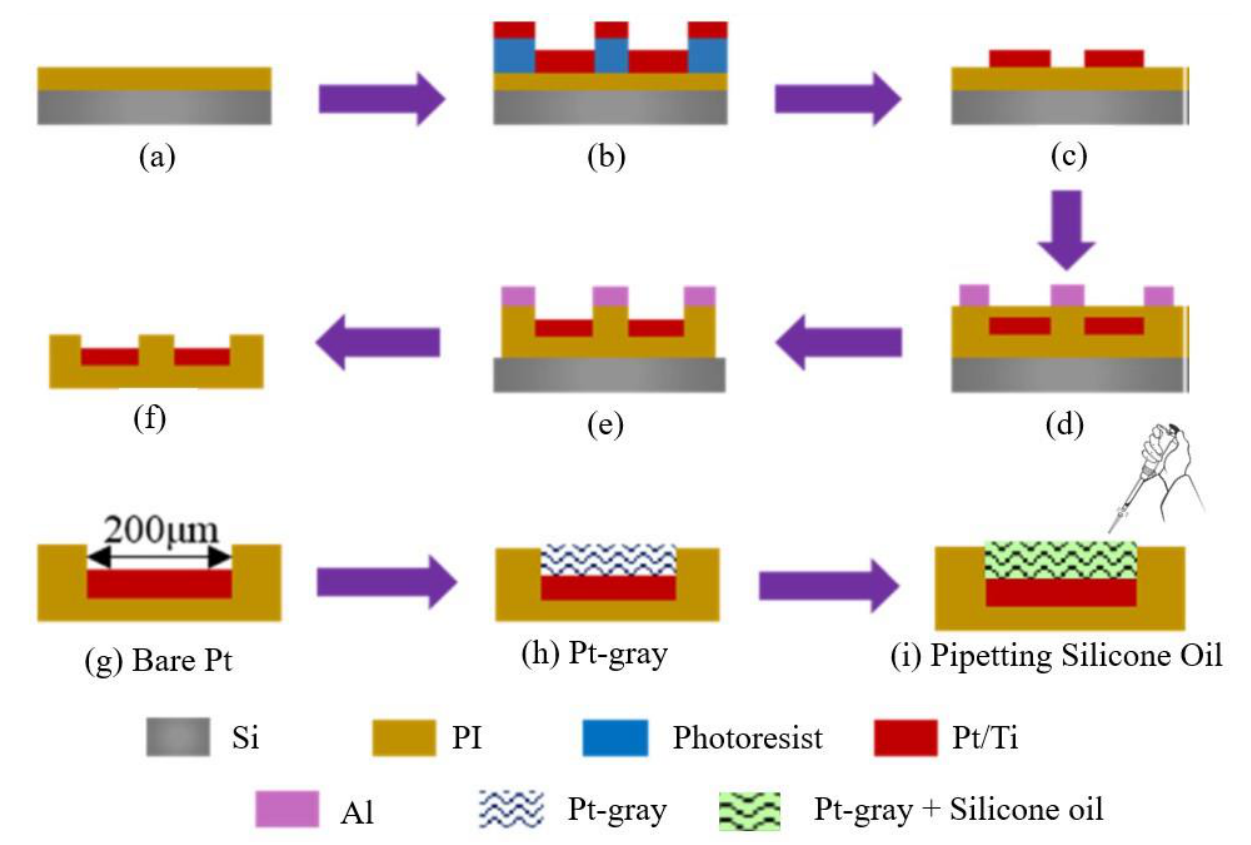
Figure 1 . Step-by-step fabrication process of the ECoG electrode, where ( a ) PI deposition on Si wafer; ( b ) sputtering process; ( c ) lift off process; ( d ) passivation of PI layer; ( e ) RIE was used for exposing Pt; ( f ) electrode was released from Si wafer; ( g , h ) surface modification for the deposition of Pt-gray for creating the nano cone structures; and ( i ) Pipetting the silicone oil .